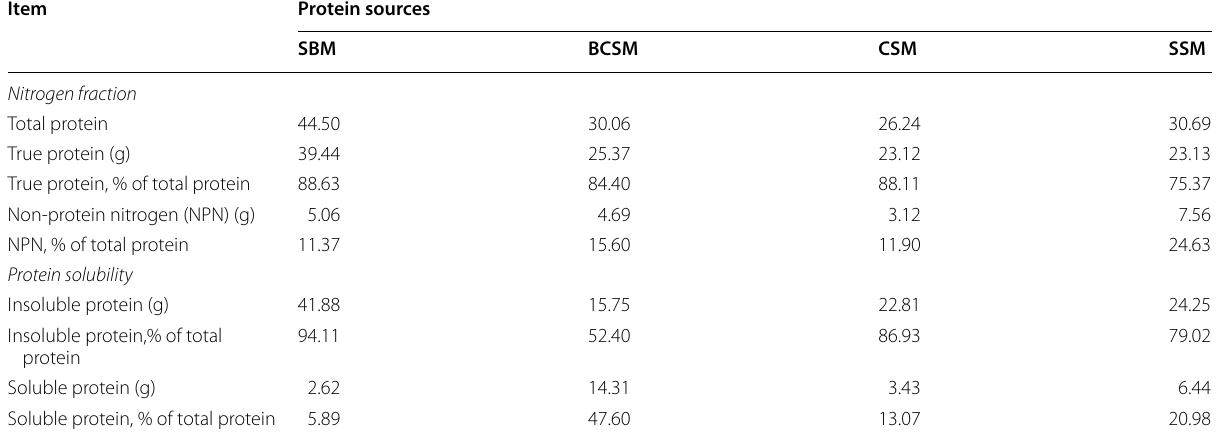
Table 3 Nitrogen fraction and protein solubility of the experimental protein sources Item